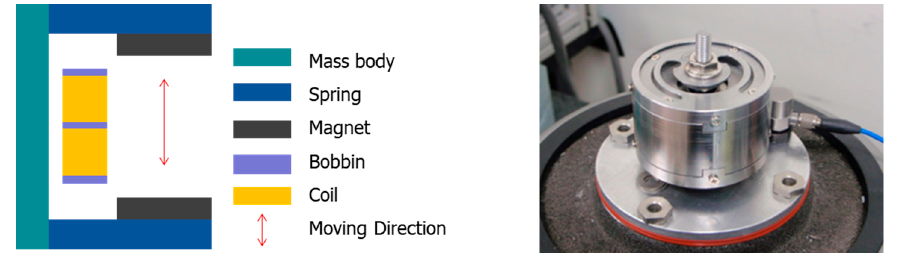
Figure 1. The schematic of the VEH device structure and the VEH device for the test.